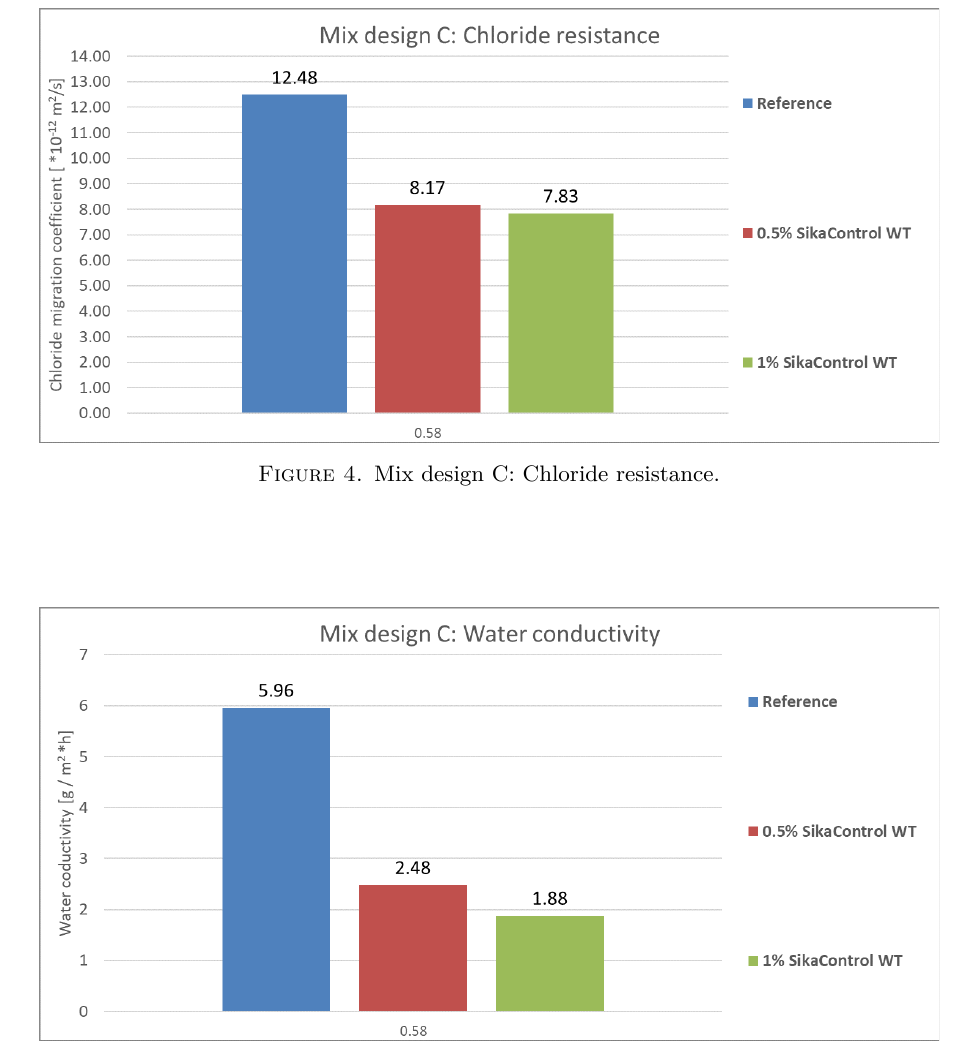
Figure 5. Mix design C: Water conductivity.